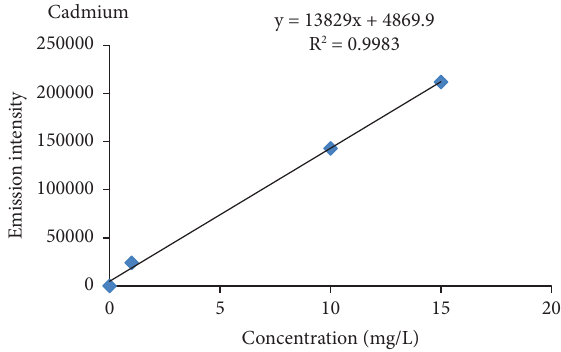
Figure 6: Standard calibration curve for